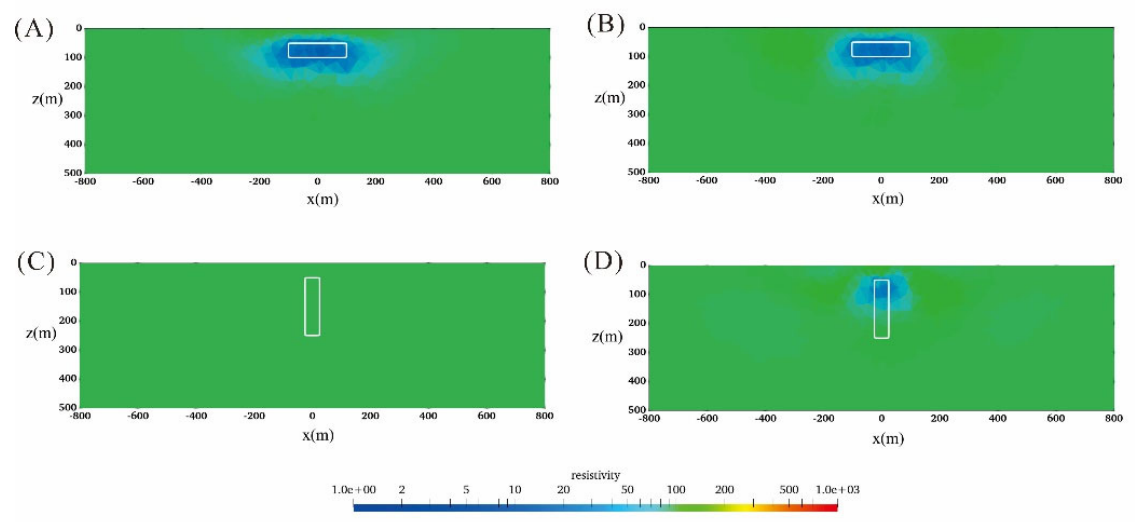
Figure 4. 3D Inversions of horizontal and vertical plate models sliced at y = 0 m. ( A ) and ( C ) are z component inversions of horizontal and vertical plate models, respectively, while ( B ) and ( D ) are multi ‐ component inversions of horizontal and vertical plate models, respectively.